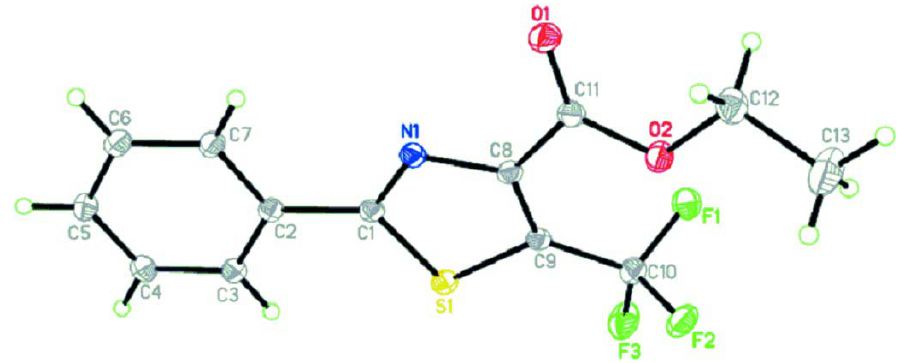
Figure 1 View of the title compound (I), shown the atom labeling scheme. Displacement ellipsoids are drawn at the 30% probability level. H atoms are represented by circles of arbitrary